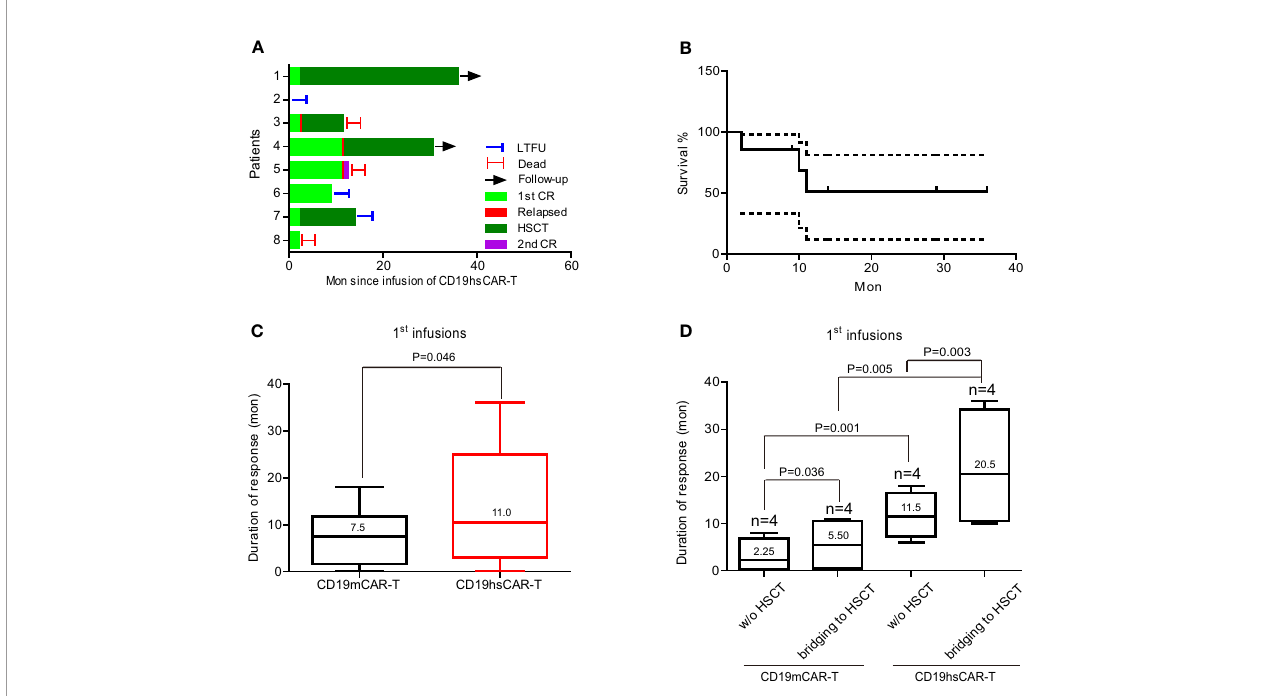
FIGURE 6 | Duration of response and survival rate of patients. (A) The duration of response of the 8 enrolled patients after infusions. (B) Survival rate after infusions. (C) Duration of response following the 1 st CD19mCAR-T or CD19hsCAR-T treatments. (D) Breakdown of duration of response into subgroups with or without HSCT. Data are presented as median values with range. LTFU, lost to